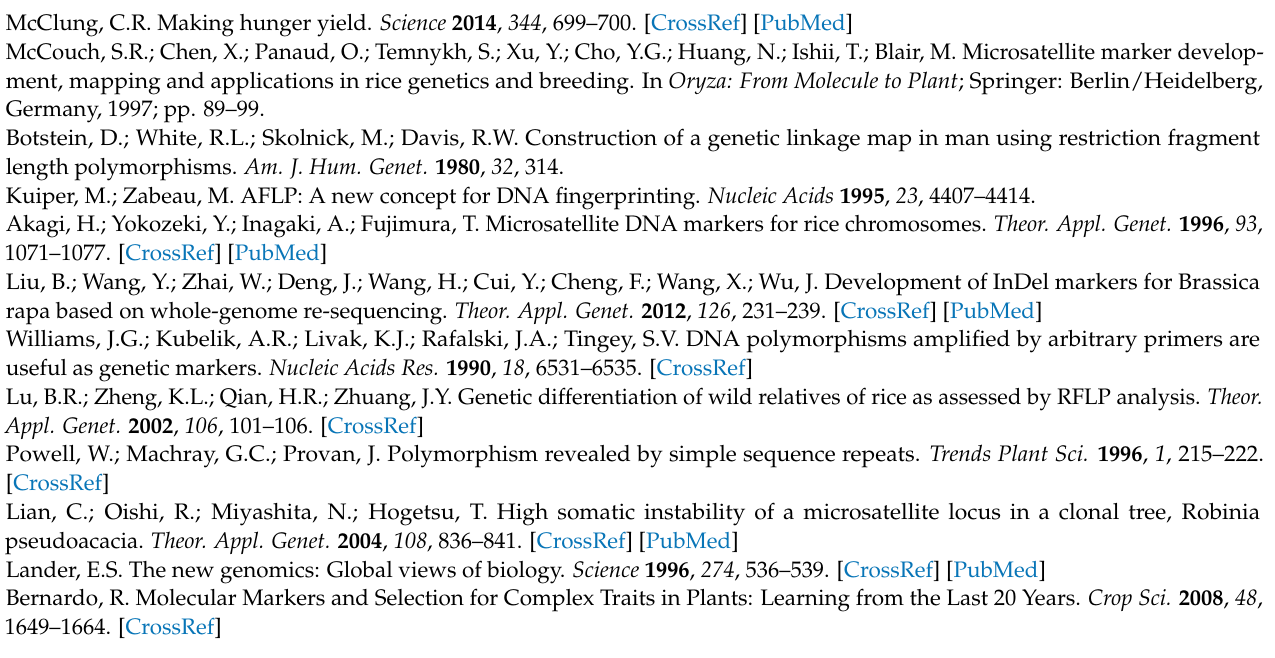
the 26 InDel markers. Figure S3: PCR amplification of the recombinant inbred lines (RILs) population. Table S1. The indica and japonica rice varieties used in this study. Table S2. The recombination inbred line progenies used in this study. Table S3. Primer sequences for 96 InDel markers used in this study. Table S4. Primer sequences for an additional 108 new InDel